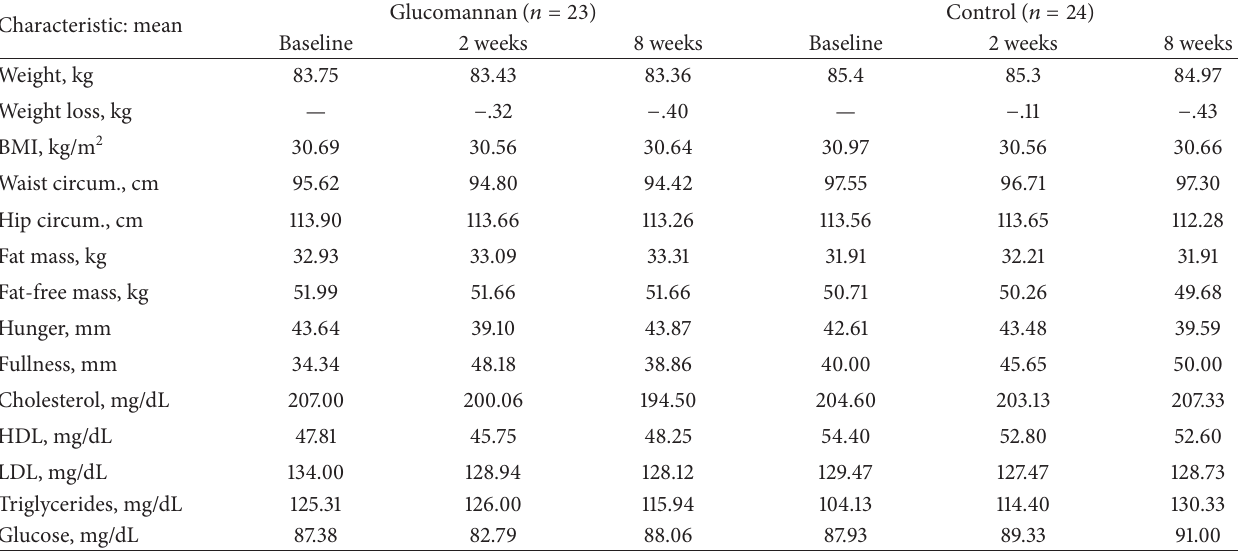
Table 2: Effects of glucomannan on efficacy outcomes (𝑁 = 47)